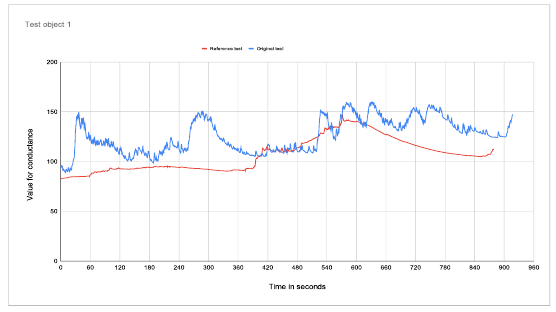
Figure 6: Plot of conductance for subject 1 Percentage change with electrodes in palm: 44,37% Percentage change with electrodes on arm: 43,43%